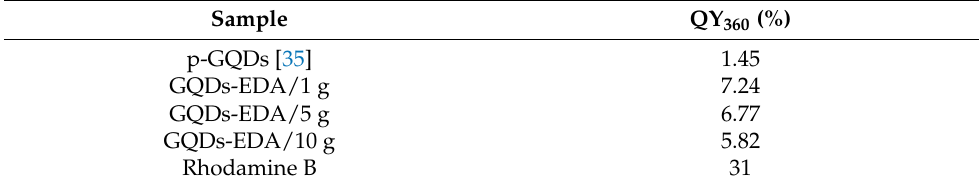
Table 3. The values of relative QY at the excitation wavelength of 360 nm.